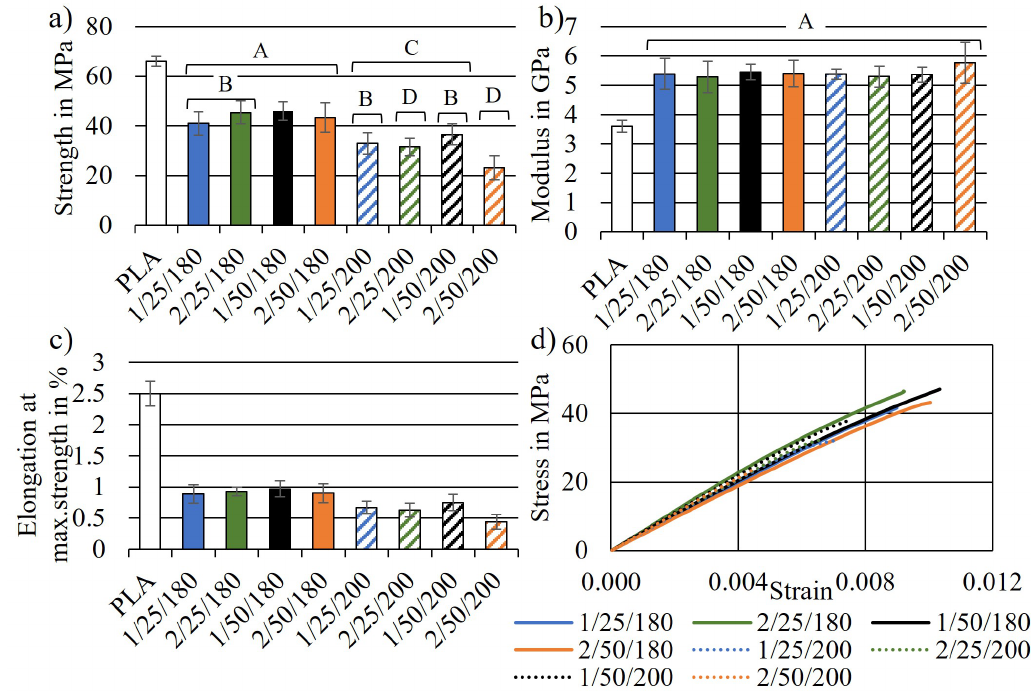
Figure 2. Results from tensile tests of the biocomposite series. ( a ) Tensile strength with indication of homogeneous groups A–D, ( b ) tensile modulus, ( c ) elongation at maximum stress and ( d ) representa- tive stress–strain curve of each